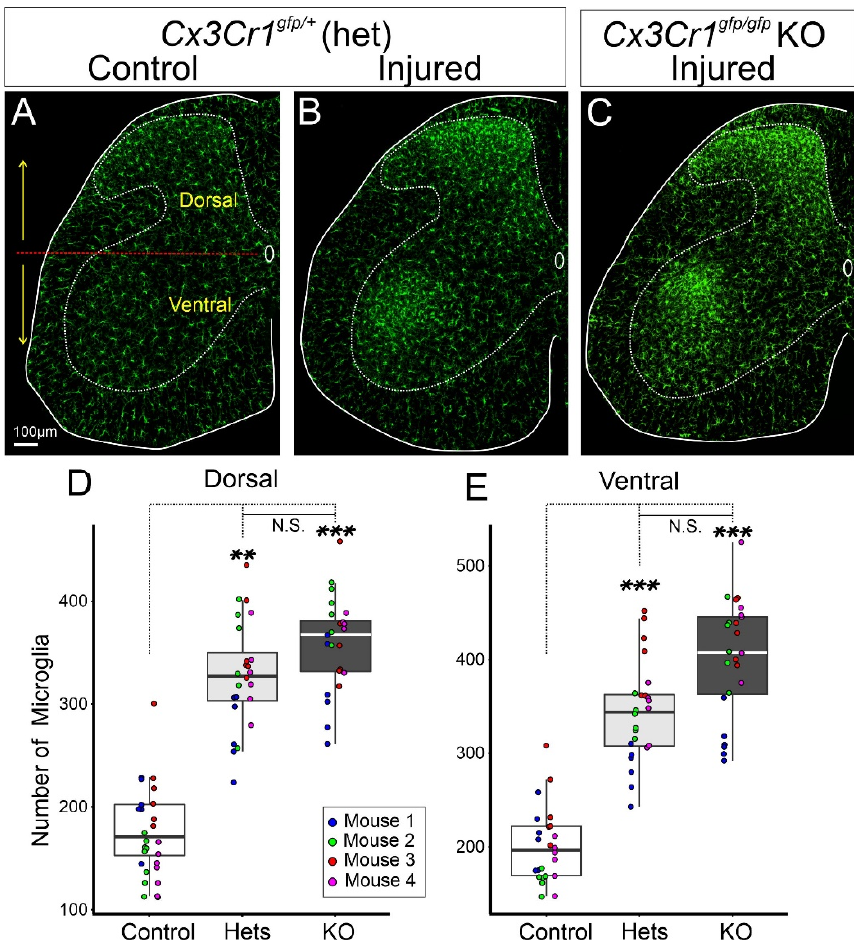
Figure 3. Lack of effect of CX3CR1 genetic removal in spinal cord microgliosis after sciatic nerve injury. ( A – C ). Low magnification confocal images showing CX3CR1-GFP microglia in a naïve spinal cord ( A ), 14 days after a sciatic nerve injury ( B ) or after the same injury in a homozygote CX3CR1 knockout mouse ( C ). The boundaries used to delimit dorsal and ventral horns are indicated by a red dash line drawn from the top of the central canal. ( D , E ). Quantification of microglia in dorsal and ventral horns of 50 µm thick sections of Lumbar 5. Four animals were analyzed for each phenotype. The number of microglia was automatically counted using the spot function in Imaris in five to seven sections per animal. Boxplots indicate the median (thick line), the box represents the 25th (Q1) and 75th (Q3) quartiles, and the whiskers represent the min ( − 1.5* Q1) and max (1.5* Q3). Each dot is a section color-coded for each animal. Following sciatic injury there is a significant increase in microglia in both dorsal and ventral horns of heterozygotes (Hets) and knockout (KO) mice. Pair-wise comparisons showed that Hets and KOs were significantly different to controls in both dorsal and ventral horns, but there was no statistical difference between them. For statistics, we used linear mixed-effect models (lme4 and emmeans packages) in R to account for variability between animals (shown by color segregation in each genotype). ** p < 0.001, *** p < 0.0001.